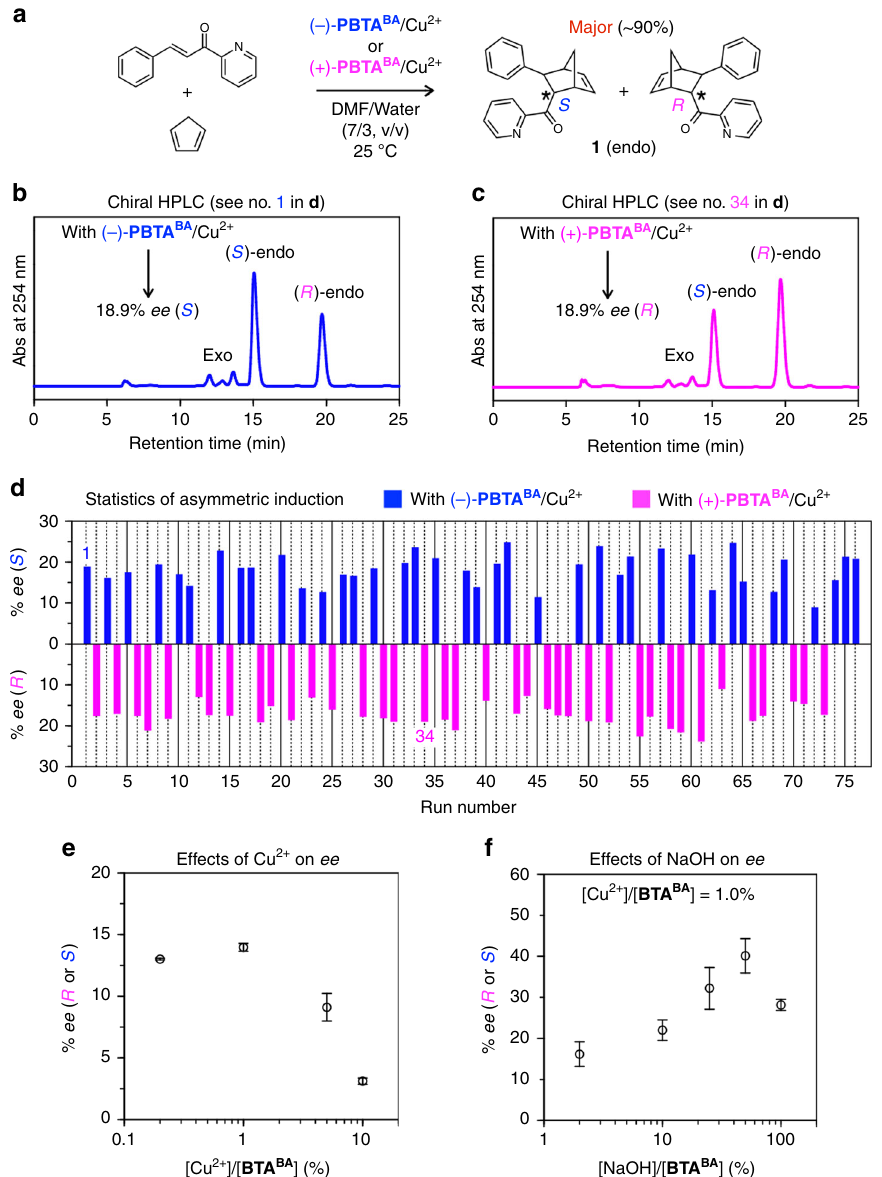
Fig. 3 Enantioselective Diels – Alder reaction catalyzed by Cu 2 + -coordinated PBTA BA nanoribbons. a Diels – Alder reaction between aza-chalcone and cyclopentadiene catalyzed by ( − )- PBTA BA /Cu 2 + or ( + )- PBTA BA /Cu 2 + , which preferentially affords the endo isomer (~90%). b , c Chiral HPLC traces of the reaction mixtures in run No. 1 ( b ) and 34 ( c ) in ( d ). Symbols ee ( S ) and ee ( R ) represent enantiomeric excess ( ee ) values of the endo isomers with the dominancy of their ( S )-endo and ( R )-endo enantiomers, respectively. d Statistical ee values of the endo isomers obtained from a total of 76 runs of the Diels – Alder reaction catalyzed at 25 °C by 76 different batches of ( – )- PBTA BA /Cu 2 + and ( + )- PBTA BA /Cu 2 + at [Cu 2 + ]/[ BTA BA ] = 1.0%. Blue and pink- colored bars represent the ee values of the endo isomers obtained when ( − )- PBTA BA /Cu 2 + and ( + )- PBTA BA /Cu 2 + , respectively, are used as the catalysts. e Effects of [Cu 2 + ]/[ BTA BA ] on the ee values of the endo isomers obtained at 25 °C with ( − )- PBTA BA /Cu 2 + or ( + )- PBTA BA /Cu 2 + . f Effects of [NaOH]/[ BTA BA ] on the ee values of the endo isomers obtained at 25 °C with ( − )- PBTA BA /Cu 2 + or ( + )- PBTA BA /Cu 2 + at [Cu 2 + ]/[ BTA BA ] = 1.0%, where NaOH was added to the suspensions of ( − )- PBTA BA or ( + )- PBTA BA prior to the addition of Cu(NO 3 ) 2 . Error bars represent the standard deviation. Source data are provided as a Source Data fi